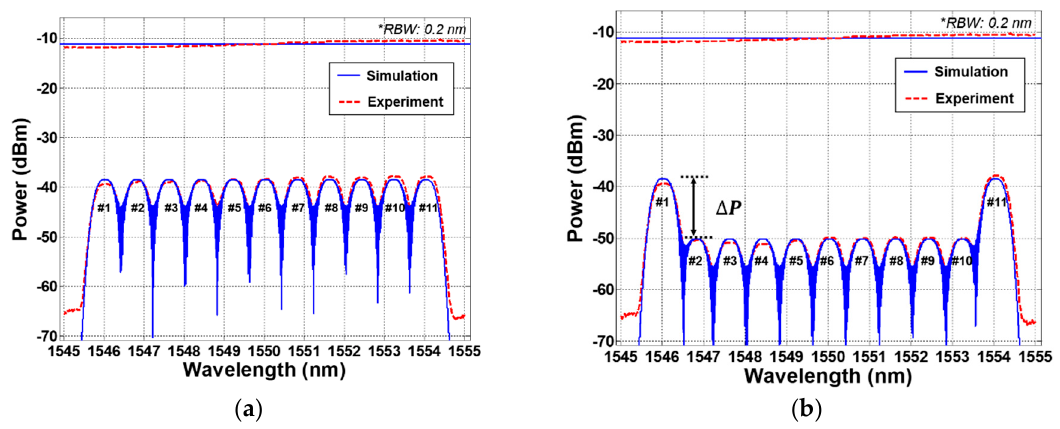
Figure 3. Simulated and measured optical spectra of the reflected spectrum-sliced amplified spontaneous emission (ASE) with wavelength division multiplexing (WDM) channels ( a ) the lowest water level, and ( b ) the full water level.